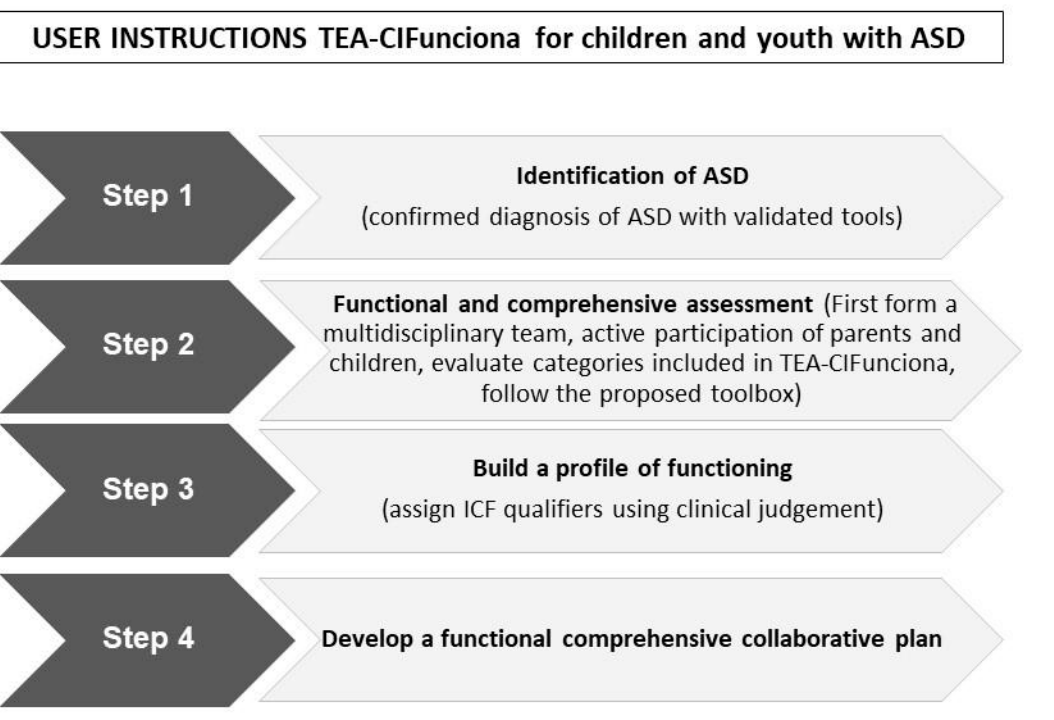
Figure 3. User instructions TEA-CIFunciona version 1.0.